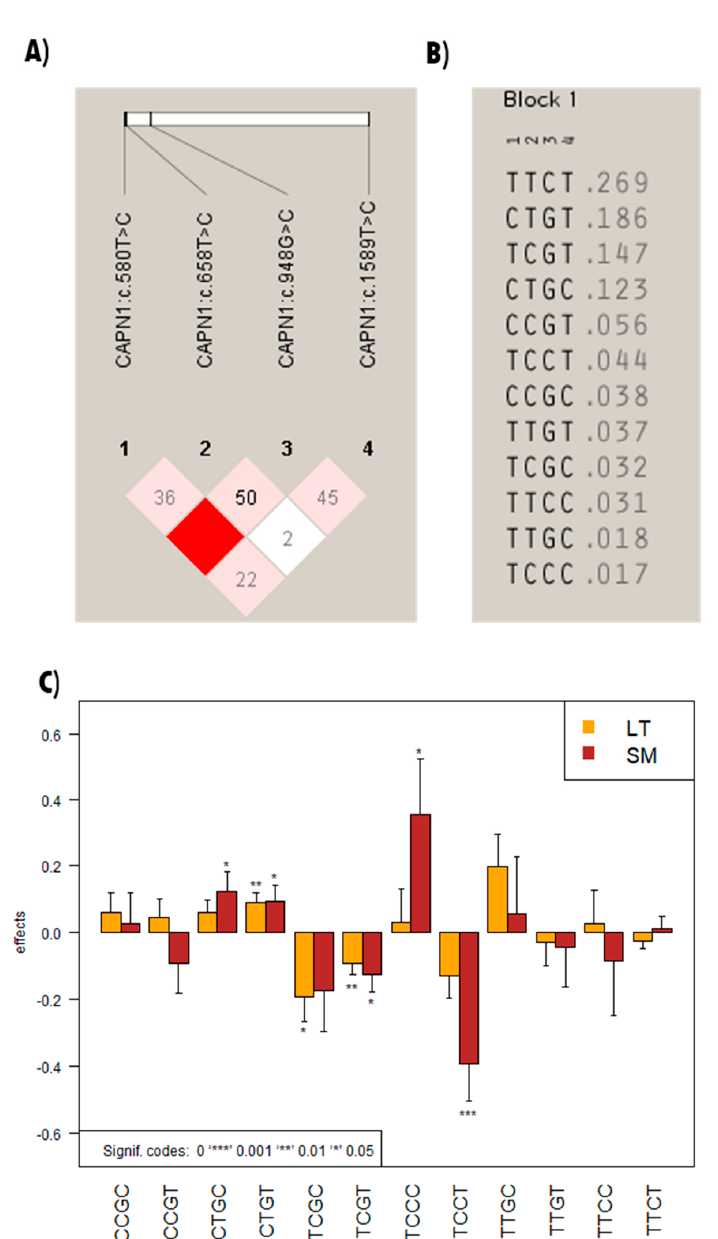
Figure 1. ( A ) Linkage disequilibrium pattern; ( B ) haplotype frequencies among the 4 SNPs in CAPN1 ; ( C ) haplotype effects on WBSF in different muscles in Hanwoo; The numbers at the top of panel ( B ) are equal to the numbers at panel ( A ) and those numbers represent each marker above.